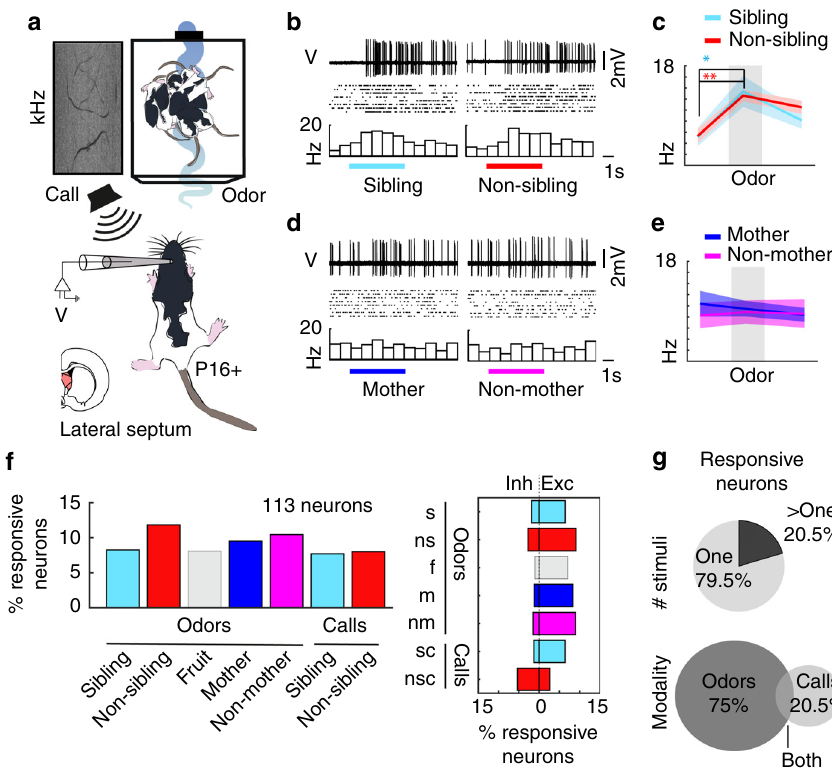
Fig. 5 Responses of lateral septum neurons to kin stimuli in sibling-avoiding old pups. a Juxta-cellular recordings of awake and anaesthetized P16 + pups with odor and vocalization stimuli. b Responses to sibling and non-sibling odor (top), raster (middle), and peristimulus time histogram (bottom). Colored lines: timing of odors. c Firing rates for baseline (left), odor (middle), and offset (right). Data represent the mean (thick line) ± s.e.m. (shaded area). Sibling odor ( n = 8 trials; mean ± s.e.m.; baseline = 5.13 ± 1.64 Hz; odor = 13.38 ± 2.80Hz; difference = 8.25 ± 3.22; p = 0.038, paired t -test). Non-sibling